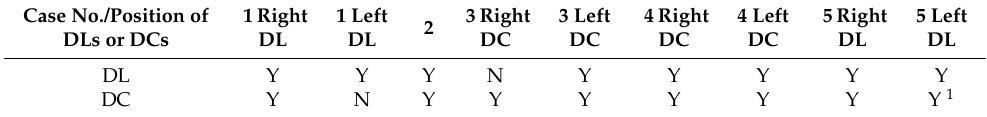
Table 2. Association between DCs and DLs. Case No./Position of DLs or